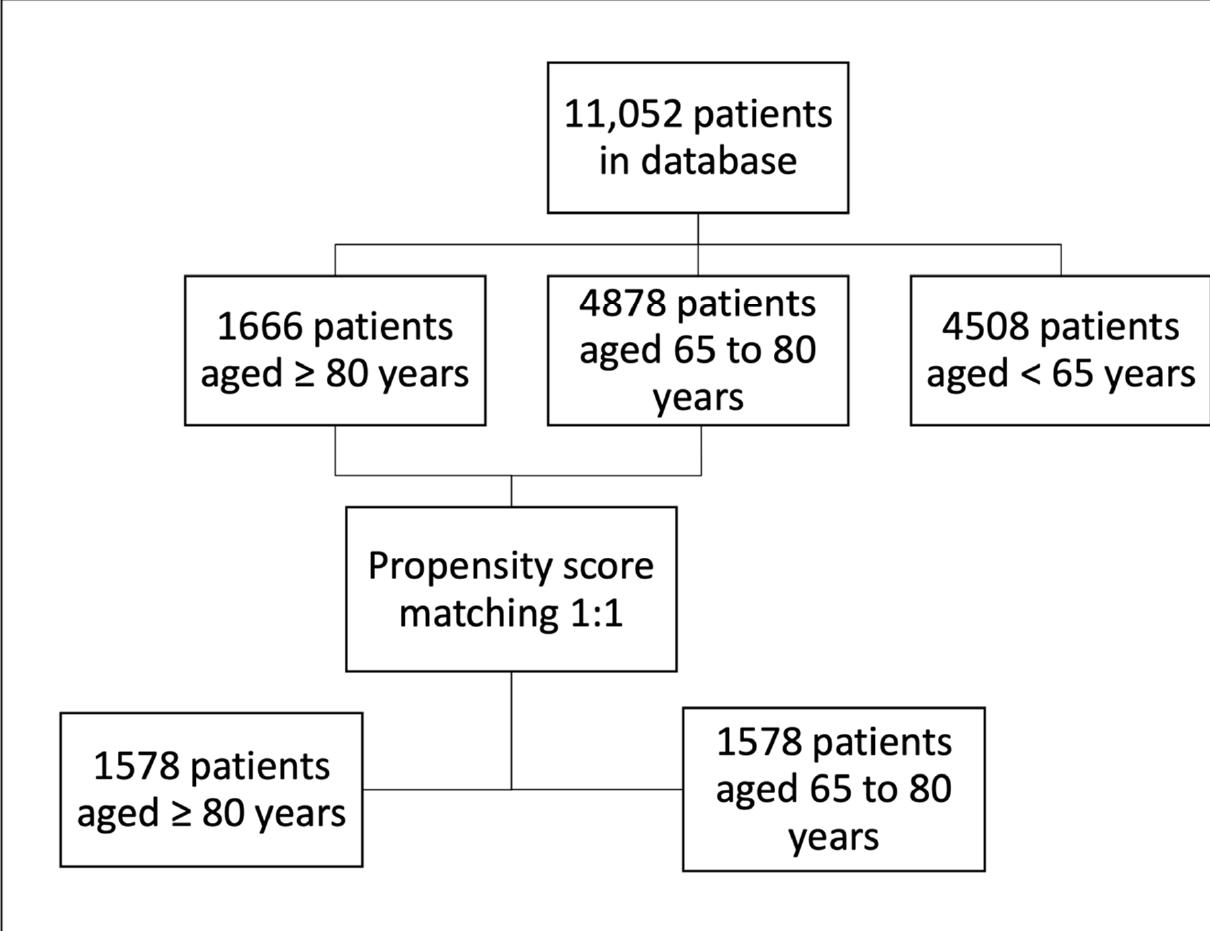
Figure 1. Study Figure 1. Study flowchart.